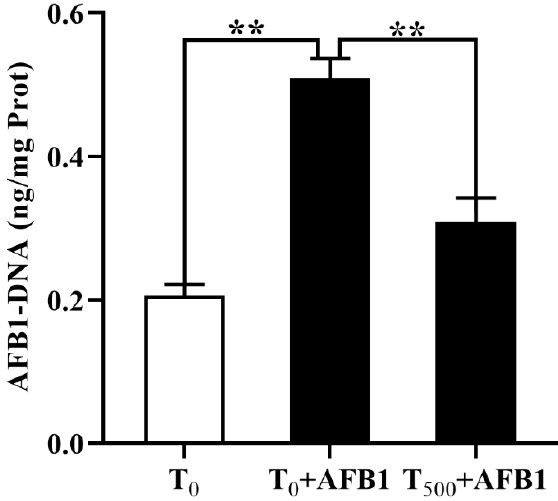
Figure 2. The aggregation of AFB1-DNA adducts in the plasma of ducks ( Anas PlatyrhynchosI ) exposed to AFB1 at 70 days. T 0 : the control group, T 0 + AFB1: AFB1 group; T 500 + AFB1: curcumin + AFB1 group. Values are expressed as Mean ± SEM ( n = 15), ** means p < 0.01.